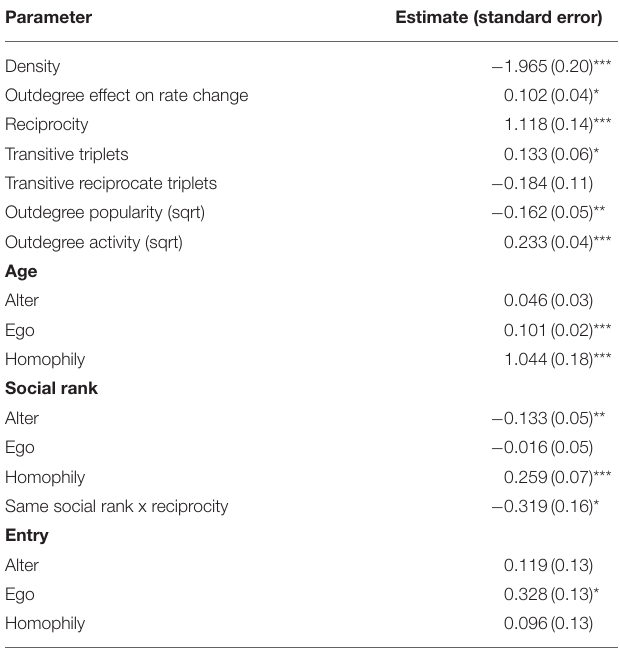
TABLE 5 | Parameter estimates of the final